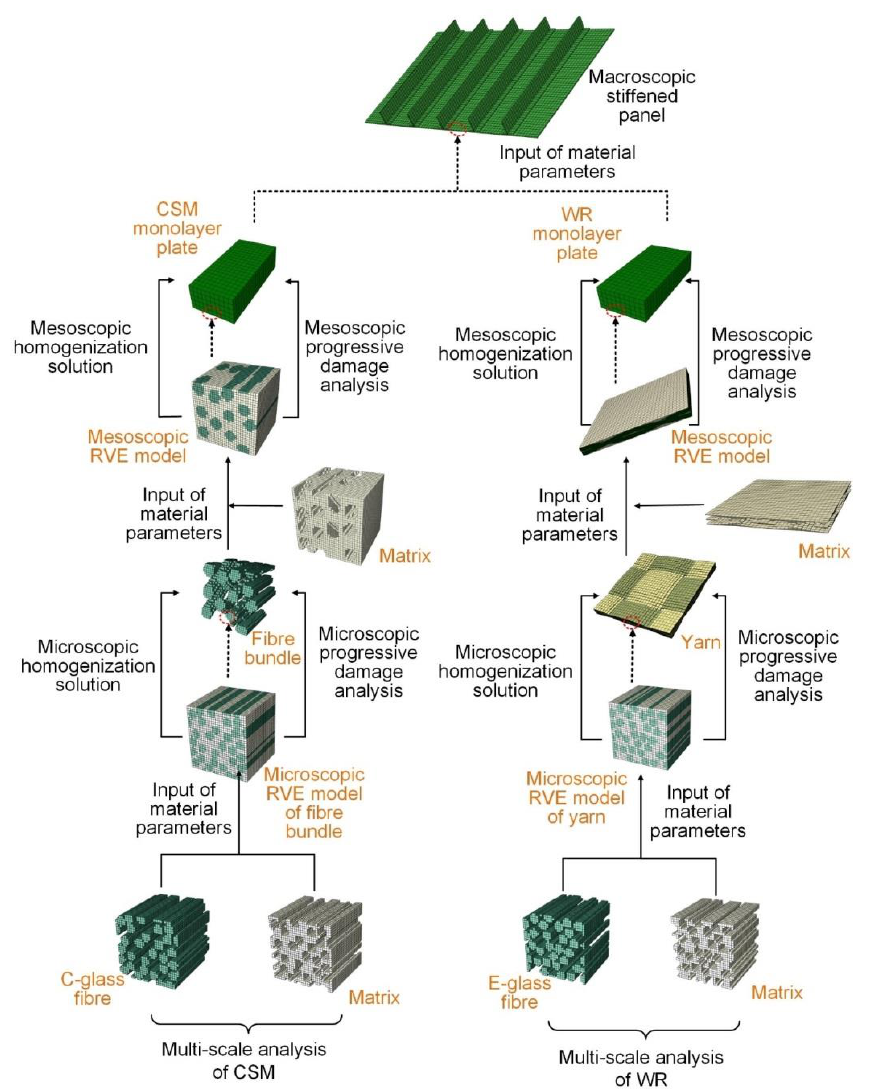
Figure 3. Analysis procedure of multi-scale method.